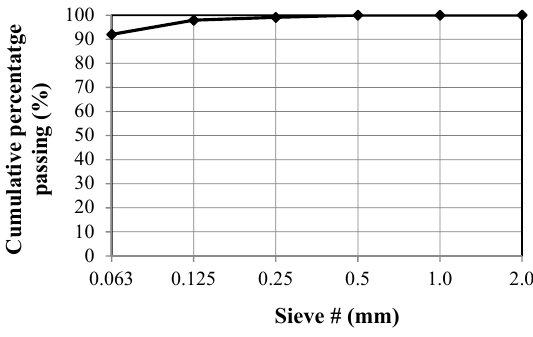
Figure 4. Grading curve of the ZeoBau 0–50 μ m natural zeolite.